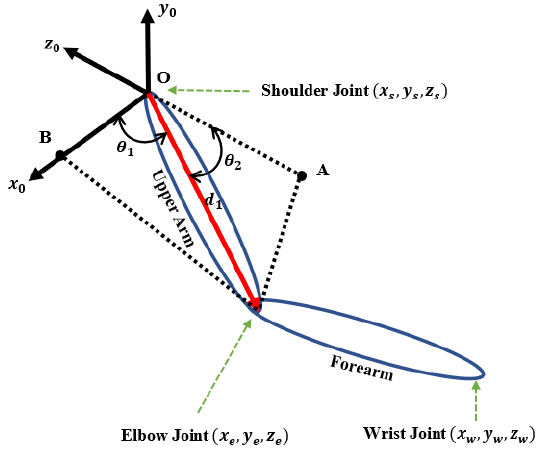
cos θ 1 = √︁ 1 − (cos θ 1 ) 2